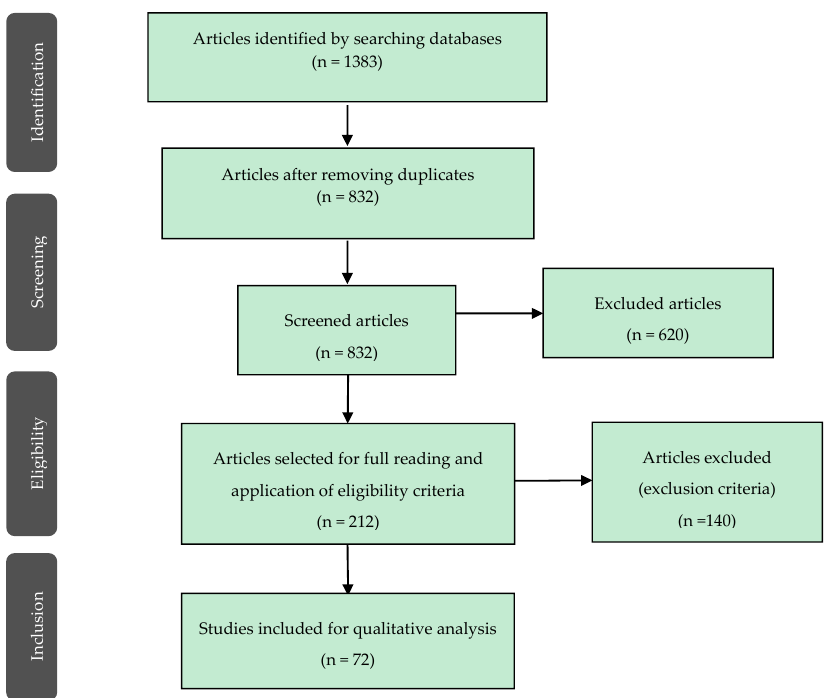
Figure 1. Search work-flow diagram.